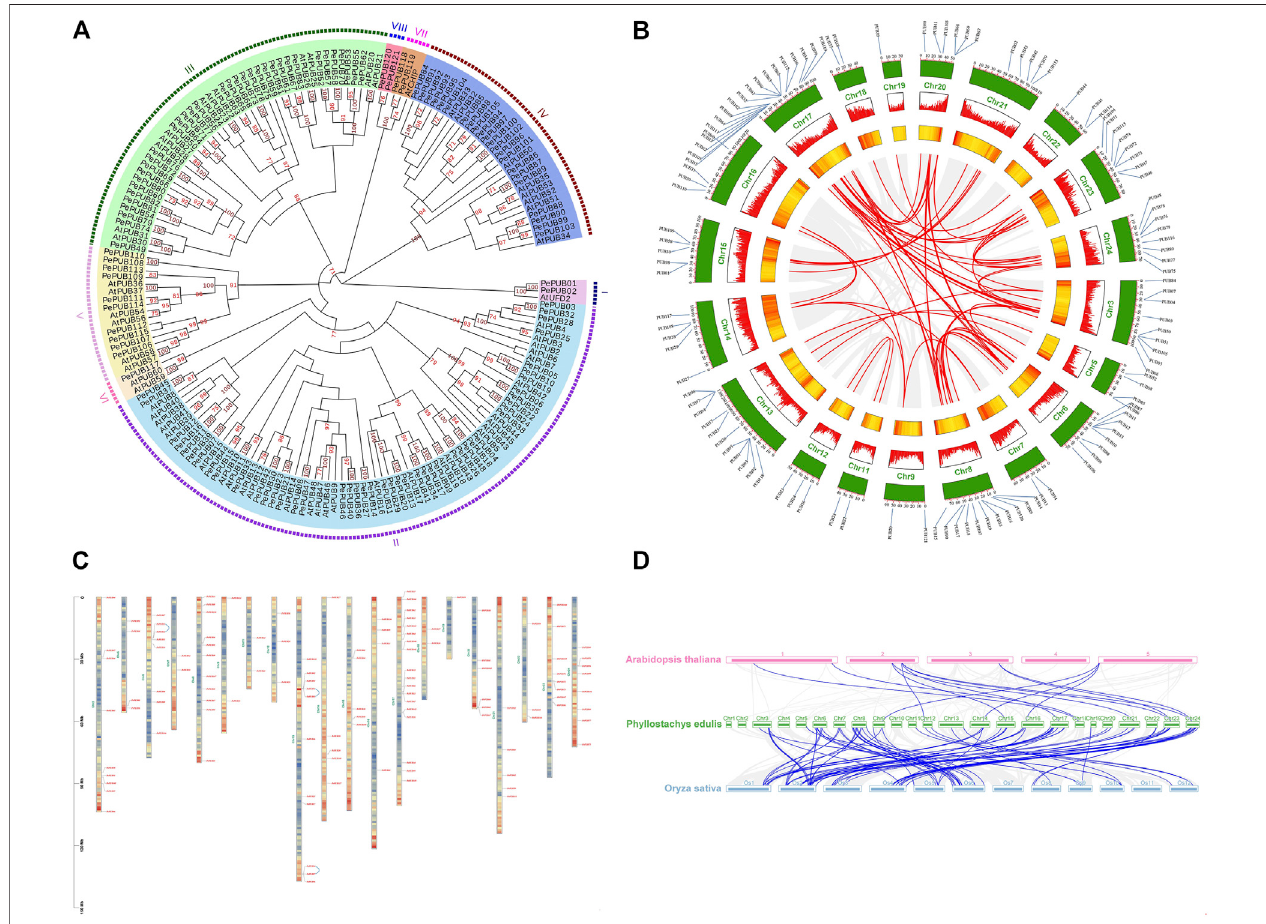
FIGURE2| Localizationandsyntenyof PePUB in Phyllostachysedulis genome. (A) Phylogeneticanalysisof PUB genesfrom Phyllostachysedulis and Arabidopsis thaliana . (B) Localization of PUB on the chromosomes. Chromosome or scaffold number was indicated on the outer side. Yellow represented different chromosomes. Thescaleinthe fi gurerepresentsthechromosomelength(Mb).Thedifferentcolorsrepresentthegenedensityofthechromosomes(increasinggenedensityfromblueto red). The ligature between genes represents the tandem duplication event. The Whole genome duplications (WGD)/segmental duplication genes were connected by blue lines. (C) Distribution of gene duplications among PePUB genes. (D) Collinearity analysis between Phyllostachys edulis and Arabidopsis thaliana and Oryza sativa . The gray line represents the co-collinearity of all genes among the three species, and the blue line represents the collinearity among members of the PUB gene